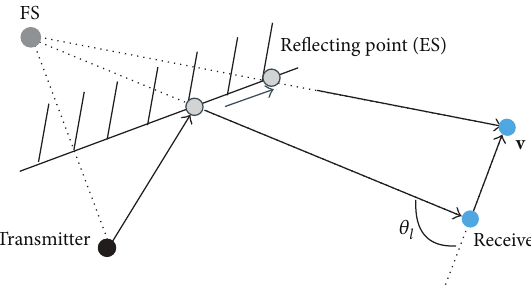
Figure 4: MPC of type M1: example of the ES located at the position of the reflection on the surface. The ES moves along a linear trajectory while the FS is fixed during receiver movement.